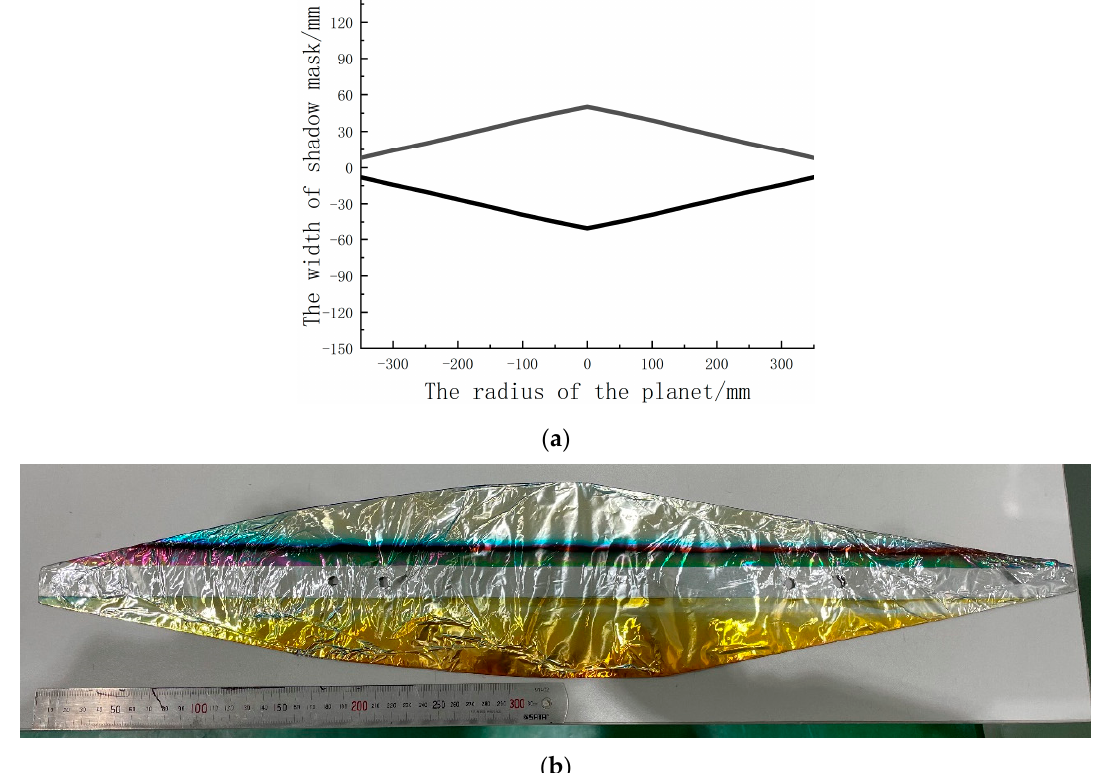
Figure 15. ( a ) Initial shape of the shadow mask. The shape is drawn by formulas (13) and (14) and the data in Table 1. Source: Author’s own conception, based on MATLAB software. ( b ) Final shape of the shadow mask. According to the experiments, the final shadow mask is obtained by making two to three adjustments based on the initial shape.